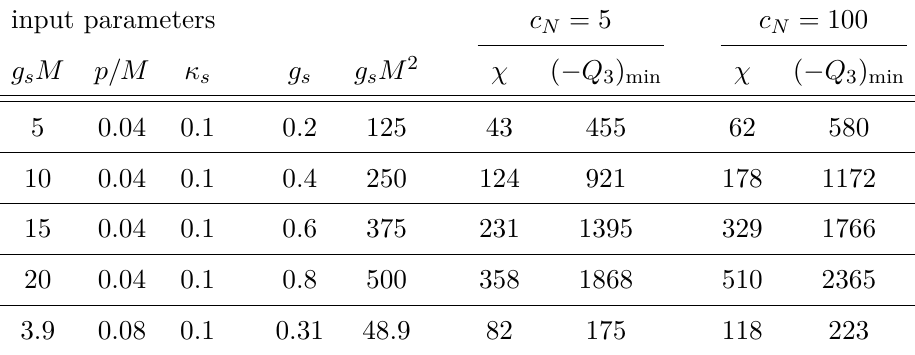
Table 2. Minimal value of the required tadpole ( − Q 3 ) min for a s = 2 π , p = 1 and different choices of p/M , c and g demanding the maximum of the corrected KPV potential to be positive. N s M